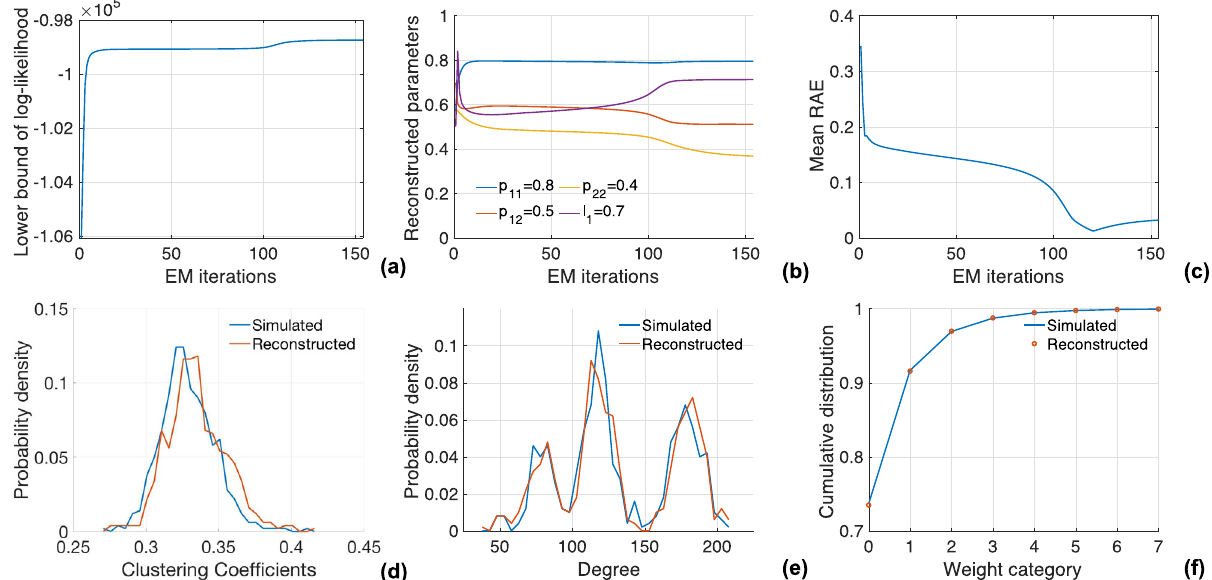
Fig. 3 Model reconstruction, graph metrics and estimation error. We investigate the estimation algorithm on a synthetic network of 500 nodes generated by the weighted multifractal graph model (WMGM) with model parameters: node attribute probability l (1) = [0.7, 0.3], linking probability p (1) = [0.8, 0.5; 0.5, 0.4], initial model size M = 2 and model iteration K = 3. We show the objective function (lower bound of log-likelihood) in a , the reconstructed parameters in b and the mean relative absolute error (RAE) per parameter in c as a function of the number of the expectation maximization (EM) iterations. The ground-truth parameters are shown in the legend of plot in b . The objective function converges and the parameters also converge to the ground-truth values. The mean RAE at the last iteration is 0.032 (3.2%). Clustering coef fi cients d , degree distribution e and weight distribution f of the simulated and the reconstructed graph. The reconstructed graph is generated by the recovered WMGM. Degree and clustering coef fi cients distributions are calculated after binarizing the simulated and the reconstructed